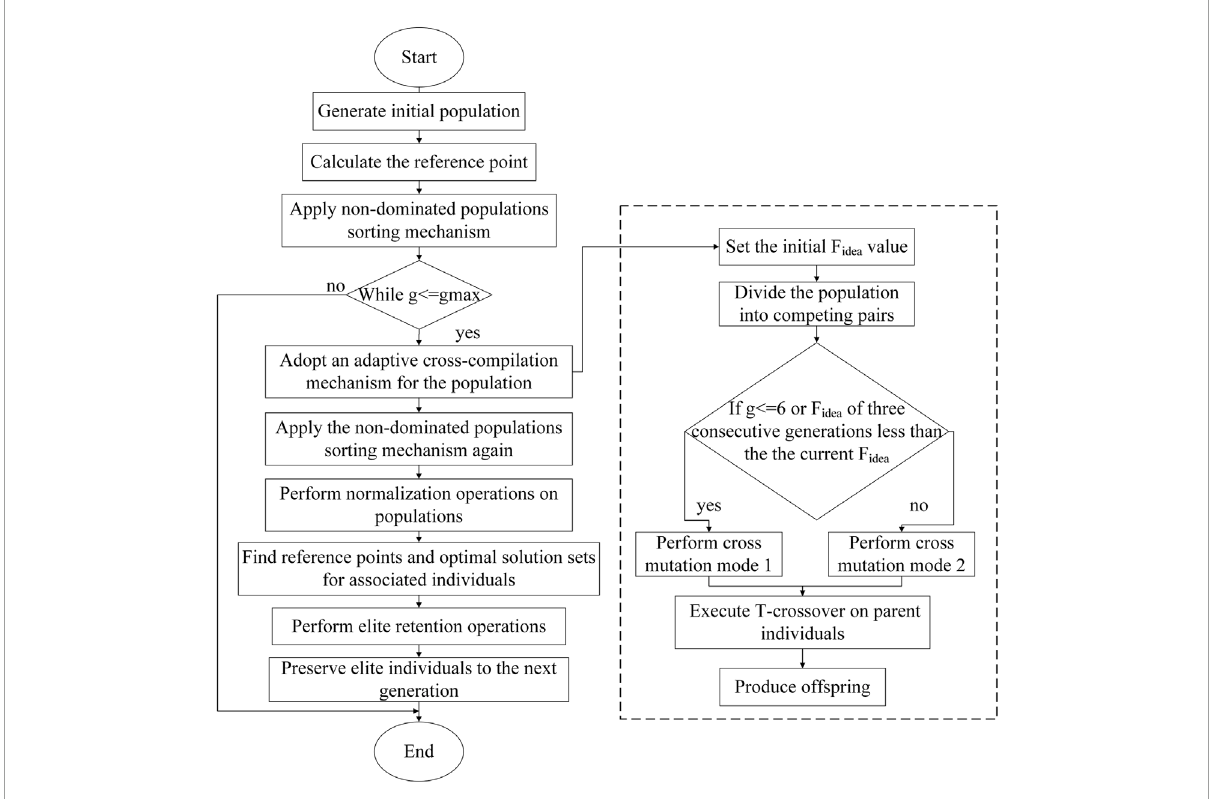
FIGURE 1 Overall flow chart of NSGA-III algorithm